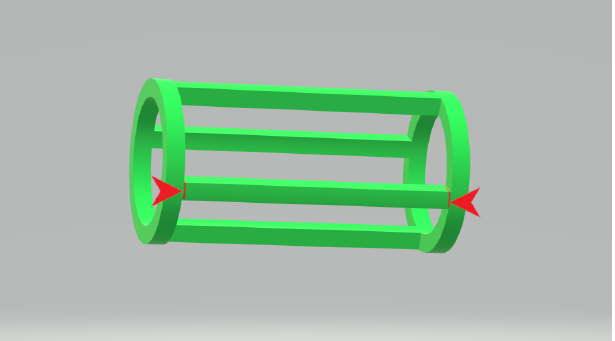
Figure 3. The elongated filament-like piece contained between the red marks was pulled apart from the structure to be used as experimental